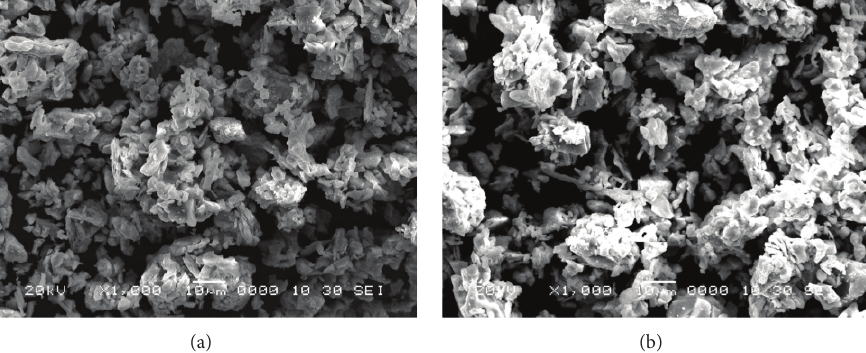
Figure 3: SEM images of (a) Ca 3 (BO 3 ) 2 :Bi 3+ and (b) Ca 3 (BO 3 ) 2 :Pb 2+ .